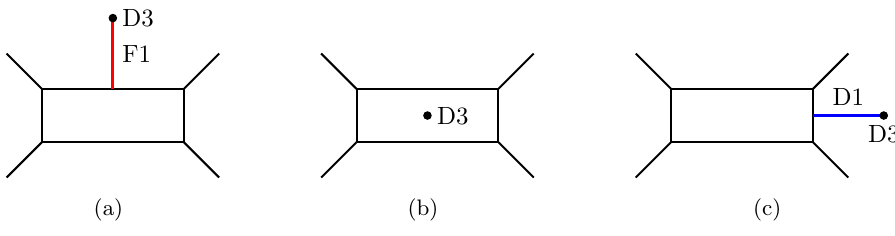
Figure 2 . 5-brane web for an SU(2) gauge theory, with a fundamental Wilson loop realized by a fundamental string on the left. In the center a con(cid:12)guration with a D3-brane in the closed face of the web. On the right a line operator realized by a D1-brane. The con(cid:12)gurations are related by Hanany-Witten